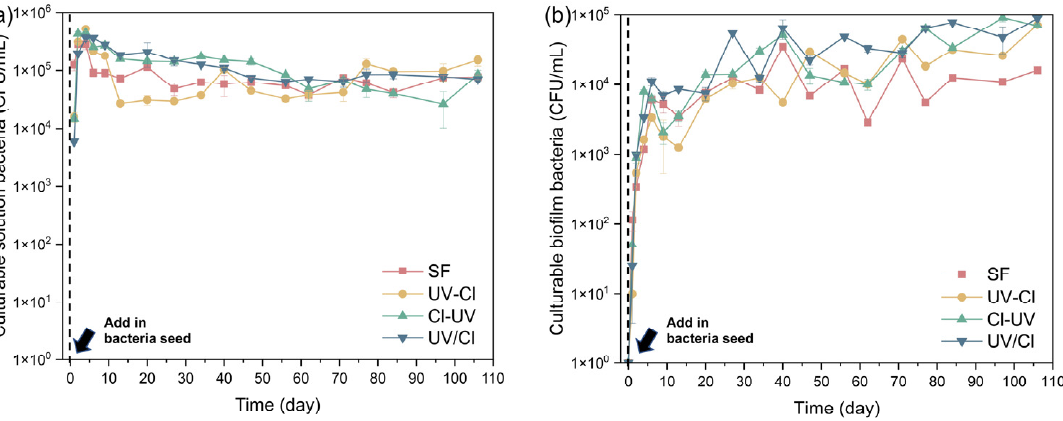
Figure 5. Culturable bacteria number in solution ( a ) and biofilm ( b ) in the reactors running with bacteria seed from day 1. Reactors were running for 106 days.